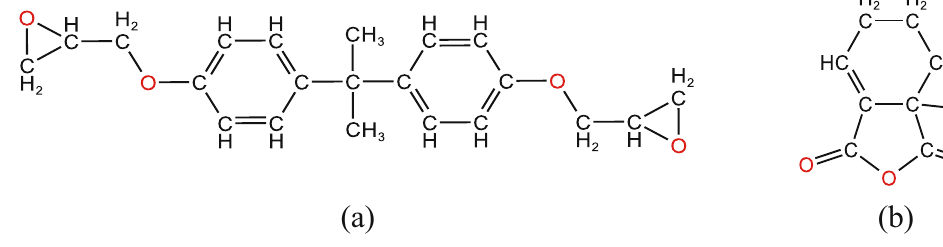
Figure 1: Molecular formula of ( a ) EP and ( b ) its curing agent MeTHPA.